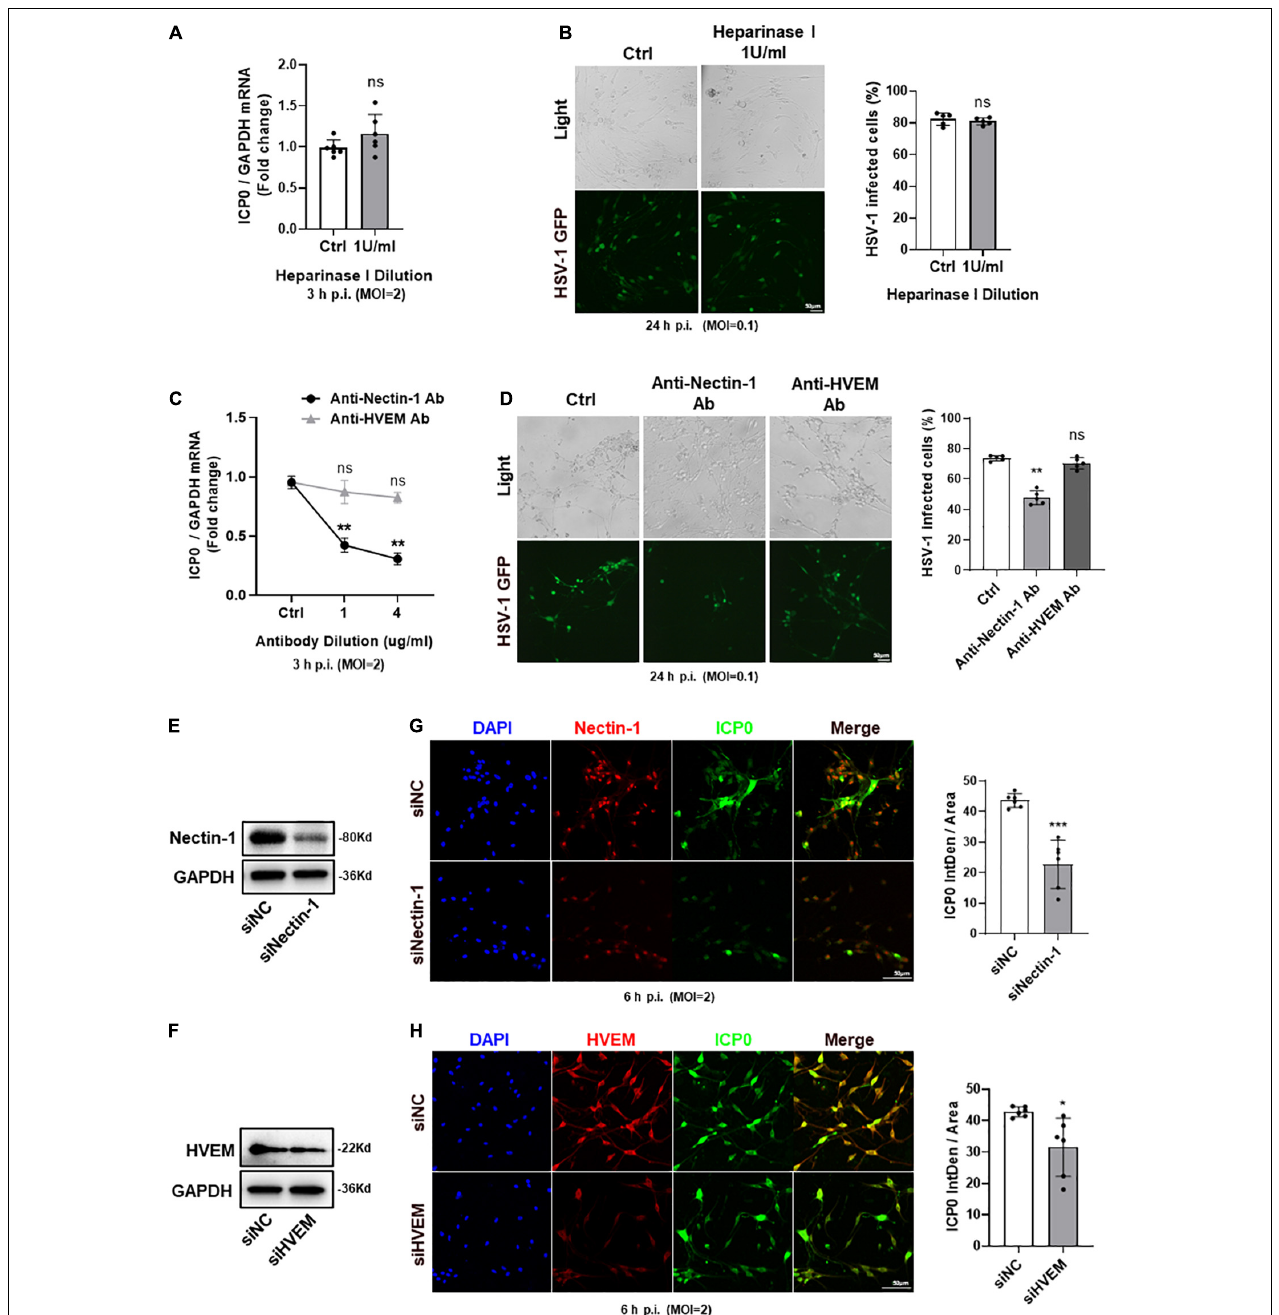
FIGURE 3 | Nectin-1 of gD receptors played the main role during HSV-1 entry into TG neurons. (A,B) TG neurons from healthy mice cultured in vitro were pretreated with indicated concentrations (U/ml) of heparinase I for 3 h before infection with HSV-1 strain McKrae or HSV-1-GFP at different multiplicities of infection (MOI). Cultured TG neurons pretreated with the same concentration of DMSO were used as control (Ctrl). ICP0 mRNA levels (A) at 3 h post-infection (h p.i.) ( n = 6) and the percentage of HSV-1-GFP infected cells (B) at 24 h p.i. ( n = 5) were assayed. There was no difference between the heparinase I treated and the Ctrl group. (C,D) Cultured TG neurons were pretreated with indicated concentrations ( µ g/ml) of anti-nectin-1 antibody (Ab) or anti-HVEM Ab before exposure to HSV-1 strain McKrae or HSV-1-GFP at different MOIs. Cultured TG neurons with the same concentration of antibody diluent were used as Ctrl. ICP0 mRNA levels (C) at 3 h p.i. ( n = 5) and the percentage of HSV-1-GFP infected cells (D) at 24 h p.i. ( n = 5) were assayed. HSV-1 infection was significantly reduced in the anti-nectin-1 Ab treatment group compared to Ctrl, while there was no change in the anti-HVEM Ab treatment group. (E,F) Nectin-1 (E) or HVEM (F) protein levels were knocked down in cultured TG neurons transfected with targeted siRNA. (G,H) Cultured TG neurons infected with HSV-1 after siRNA knockdown. At 6 h p.i., immunofluorescence analysis of ICP0 expression shows that the entry of HSV-1 was inhibited in both sinectin-1 (G) and siHVEM (H) groups, but the inhibition was more significant in the sinectin-1 group. Semi-quantitative analysis of immunofluorescence was performed by Image J ( n = 6). Bars denote SD. Ns, not significant, * P < 0.05, ** P < 0.01, and *** P < 0.001 vs. Ctrl or siNC.